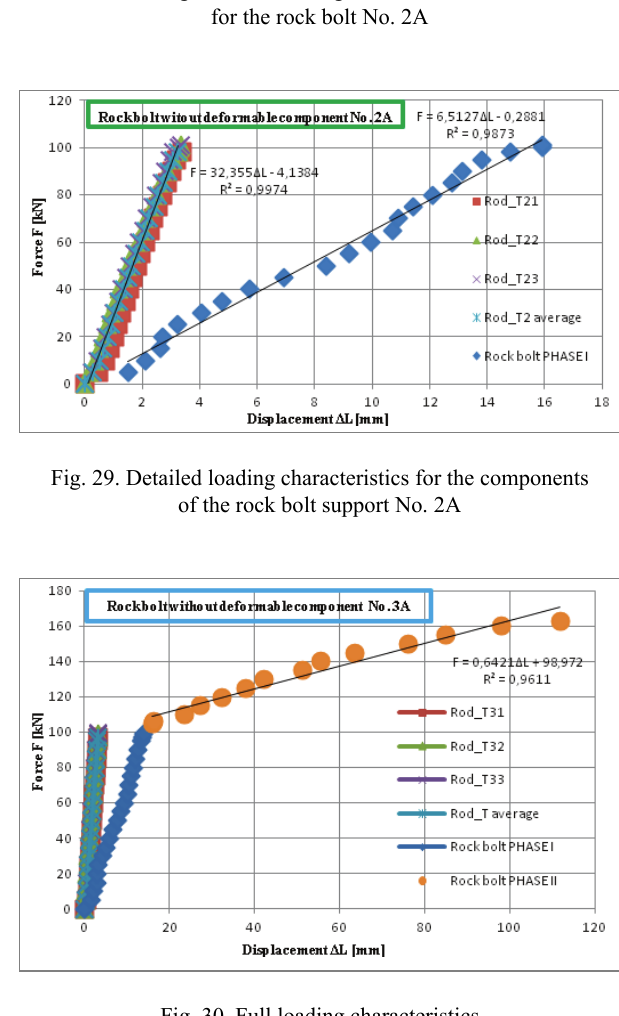
Fig. 30. Full loading characteristics for the rock bolt No. 3A